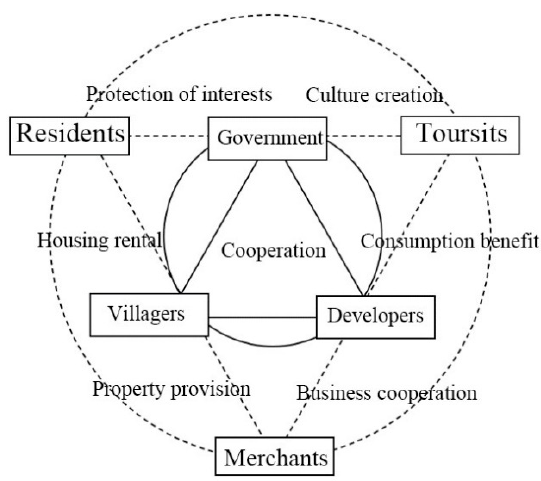
Figure 4. Diagram of the relationship between the public demand and core stakeholders.